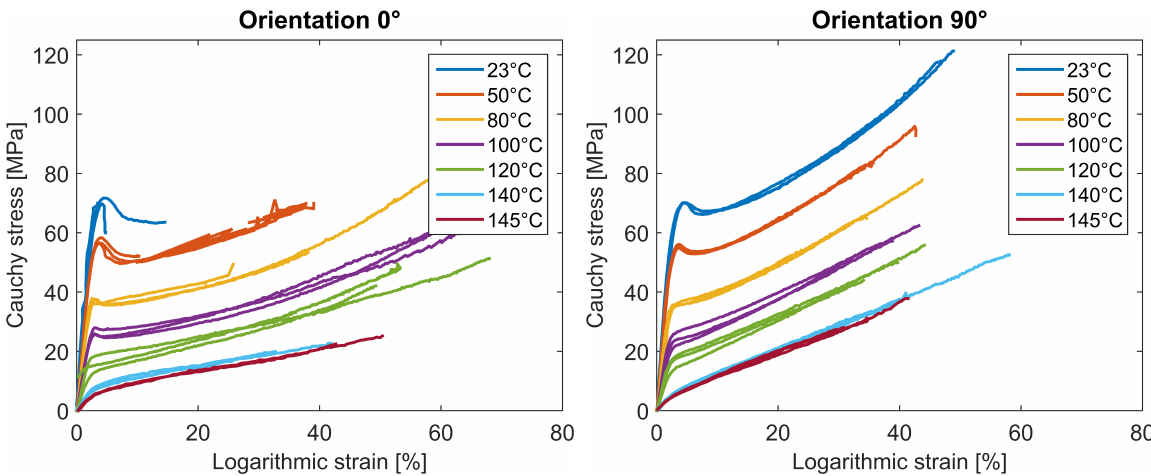
Figure 5. Relation between logarithmic strain and Cauchy stress – results for different orientation of specimen.